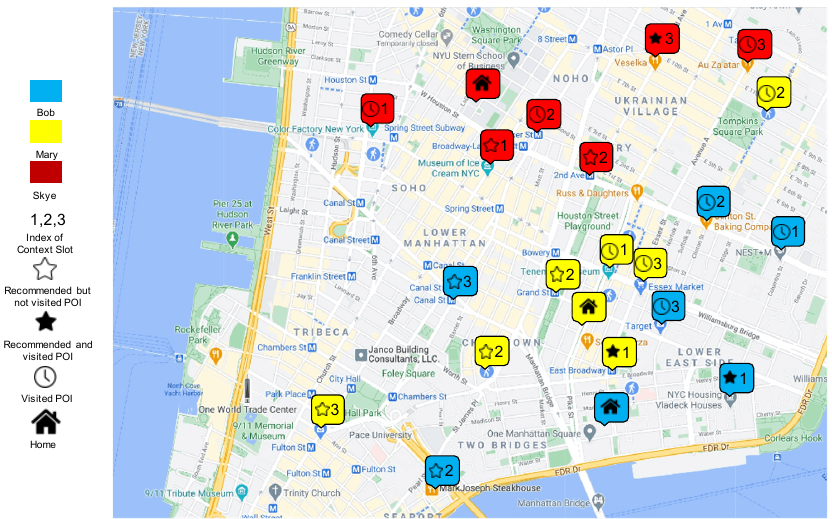
Figure 7. Spatial visualization of POI